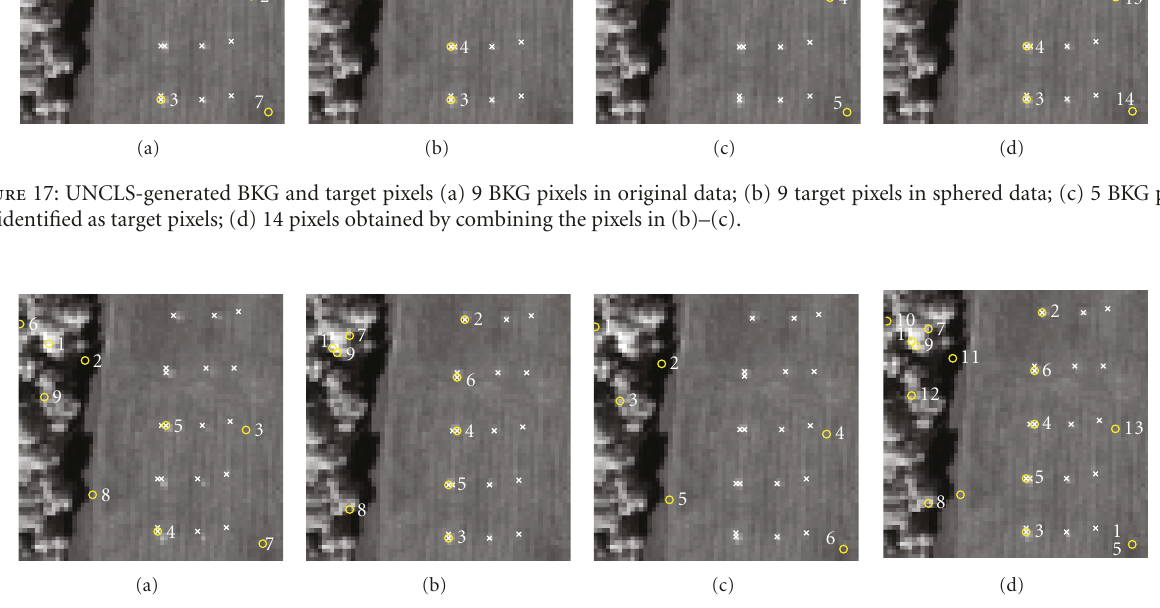
Figure 18: UFCLS-generated BKG and target pixels, (a) 9 BKG pixels in original data; (b) 9 target pixels in sphered data; (c) 6 BKG pixels not identified as target pixels; (d) 15 pixels obtained by combining the pixels in (b)–(c).